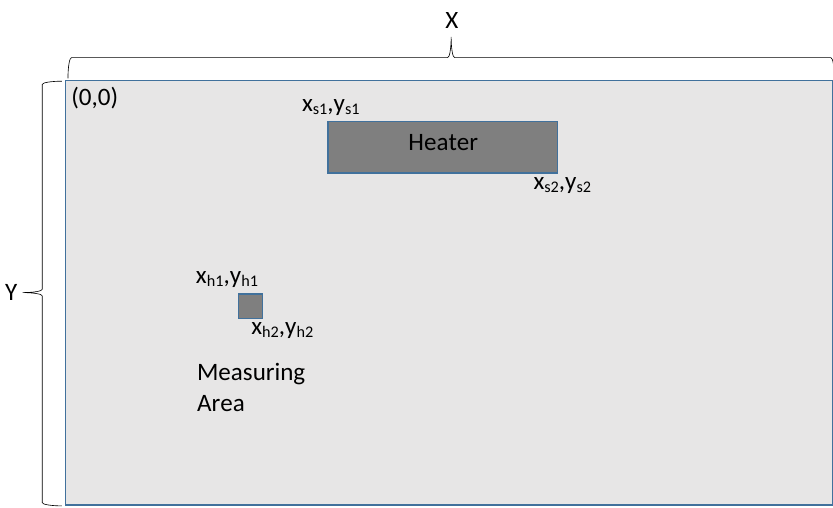
Figure 1. The simplified scheme of the experimental system. origin of the coordinate system is located in the left upper